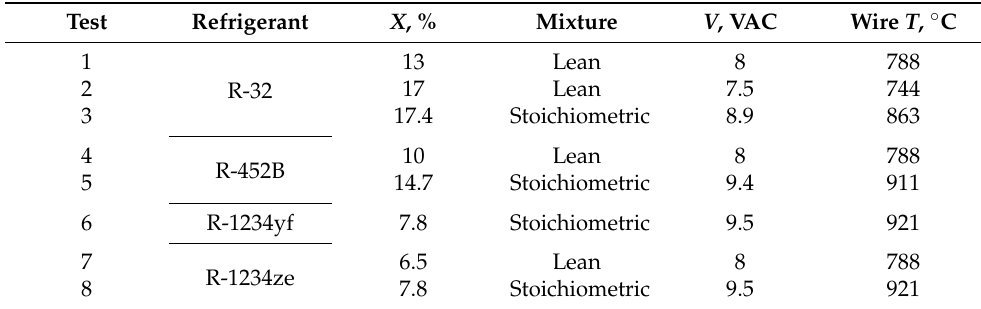
Table 2. Hot wire tests that resulted in ignition.